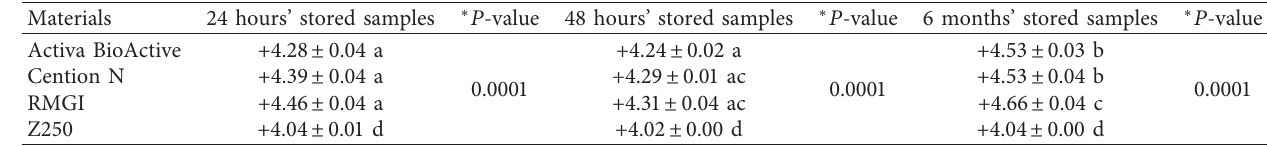
Table 3: Mean values of pH after 60 minutes of acidification of the sample environments (pH � 4.00 ± 0.01) in which the stored restorative materials (24 hours, 48 hours, and 6 months) were